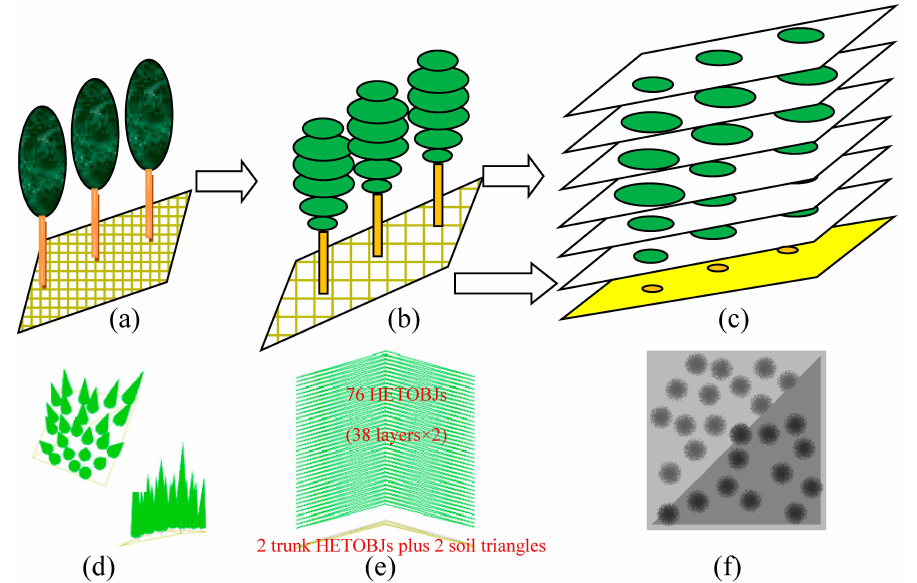
Figure 5. The illustration of sloped scenes using HETOBJs: ( a ) a forest stand with three trees on a slope; ( b ) abstraction of the forest in ( a ) using 18 HOMOBJs; ( c ) abstraction of the forest in ( a ) using only 7 HETOBJs; ( d ) a cone-shape forest stand with 25 trees on a ridge; ( e ) abstraction of the forest in ( d ) using 78 HETOBJs and 2 soil triangles; ( f ) dynamically projected object sequence ID image of the forest in ( e ) using the method in Section 3.2.